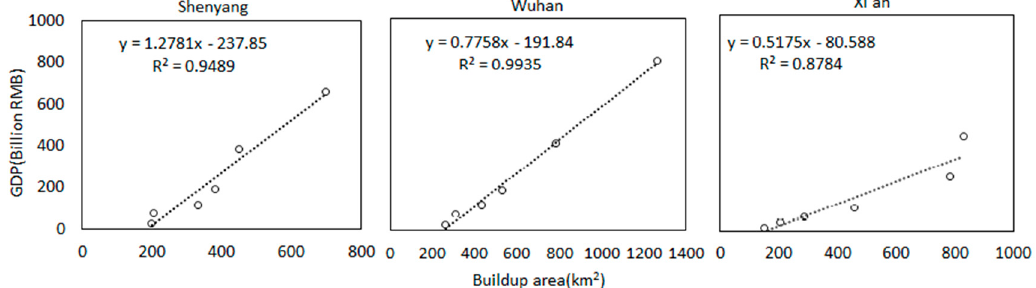
Figure 15. Correlations between built-up areas and gross domestic product (GDP) values.